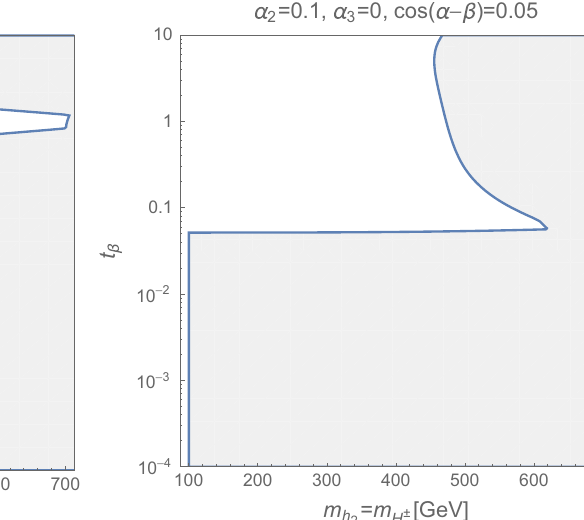
Fig. 1 Parameter space in terms of m h are excluded by unitarity and stability bounds. v s = 2 m h cos (α − β) = 0 . 05 with m h